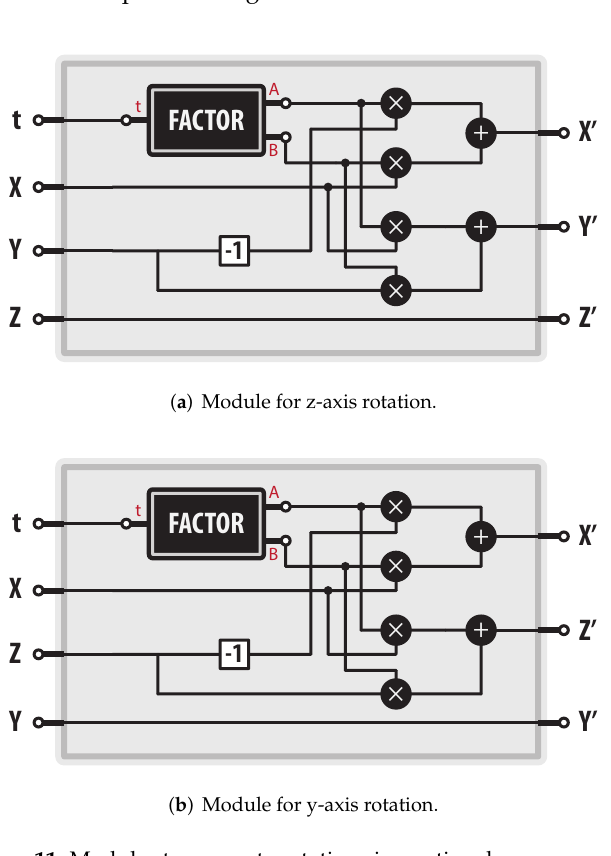
Figure 11. Modules to compute rotations in a rational